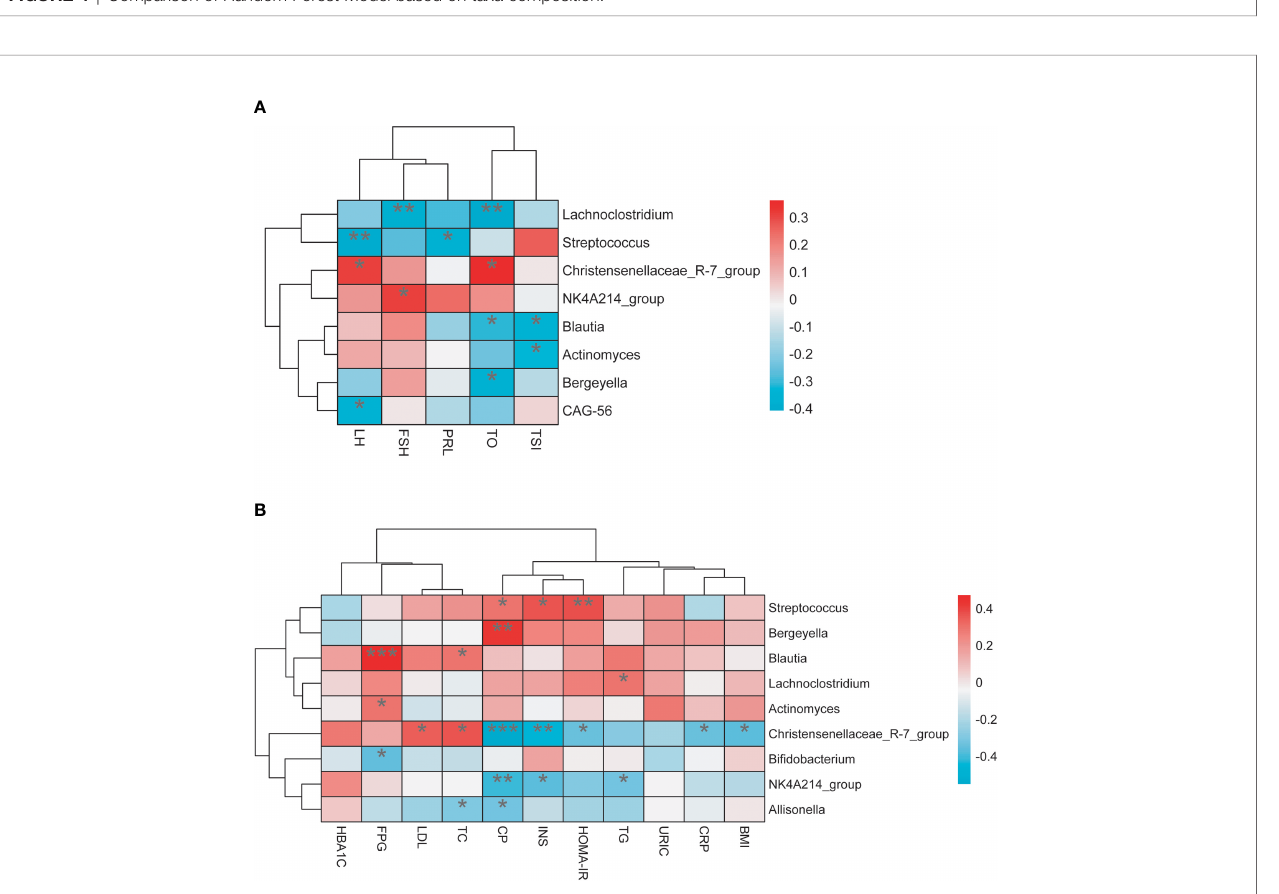
FIGURE 5 | (A) The relationship between gut microbiota and sex hormone. (B) The relationship between gut microbiota and related metabolic indicators. *P < 0.05, **P < 0.01, ***P <